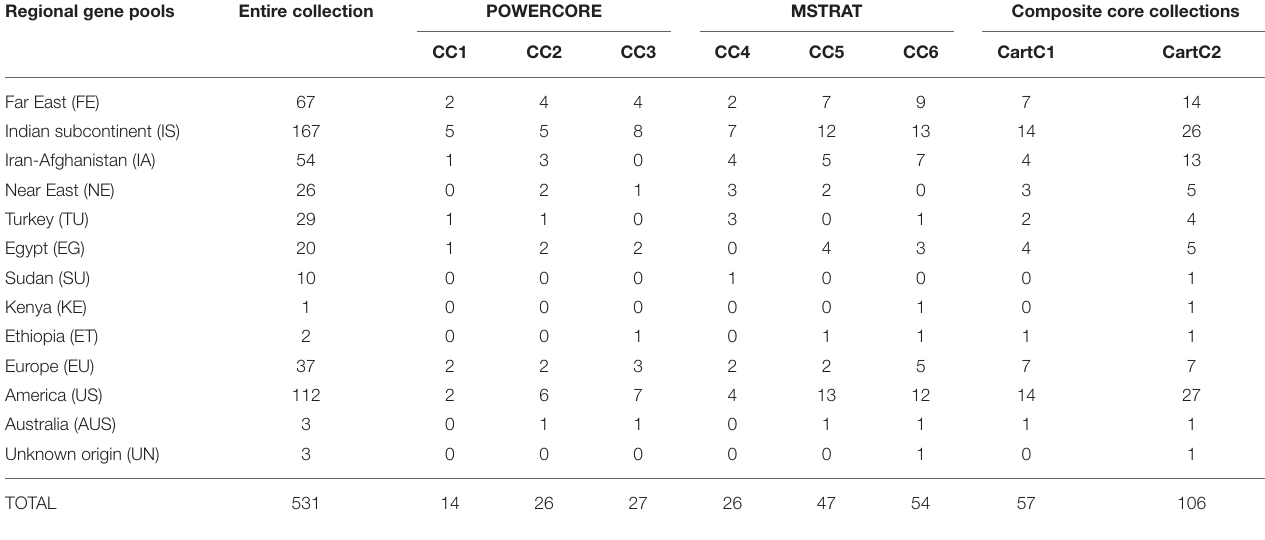
TABLE 5 | Representation from different regional gene pools of safflower in developed core collections (CC). Regional gene